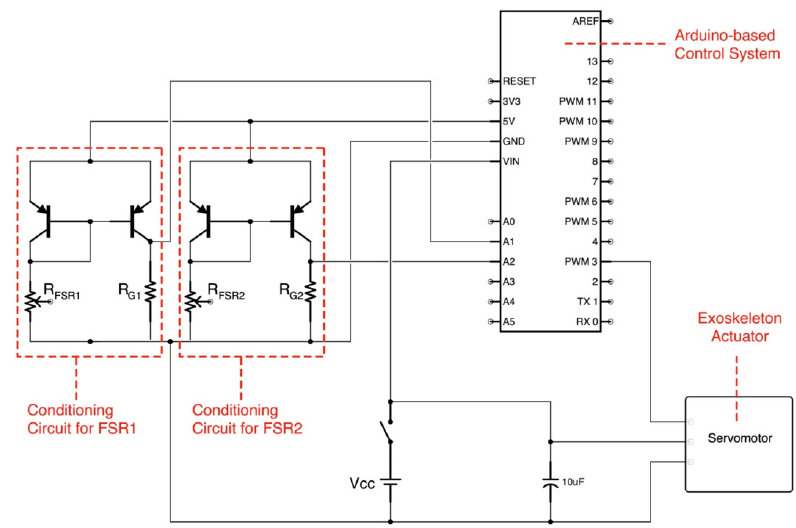
Figure 3. Circuit diagram of the control system based on an Arduino board (R G1-2 = 10 K Ω ; C = 0.47 mF).